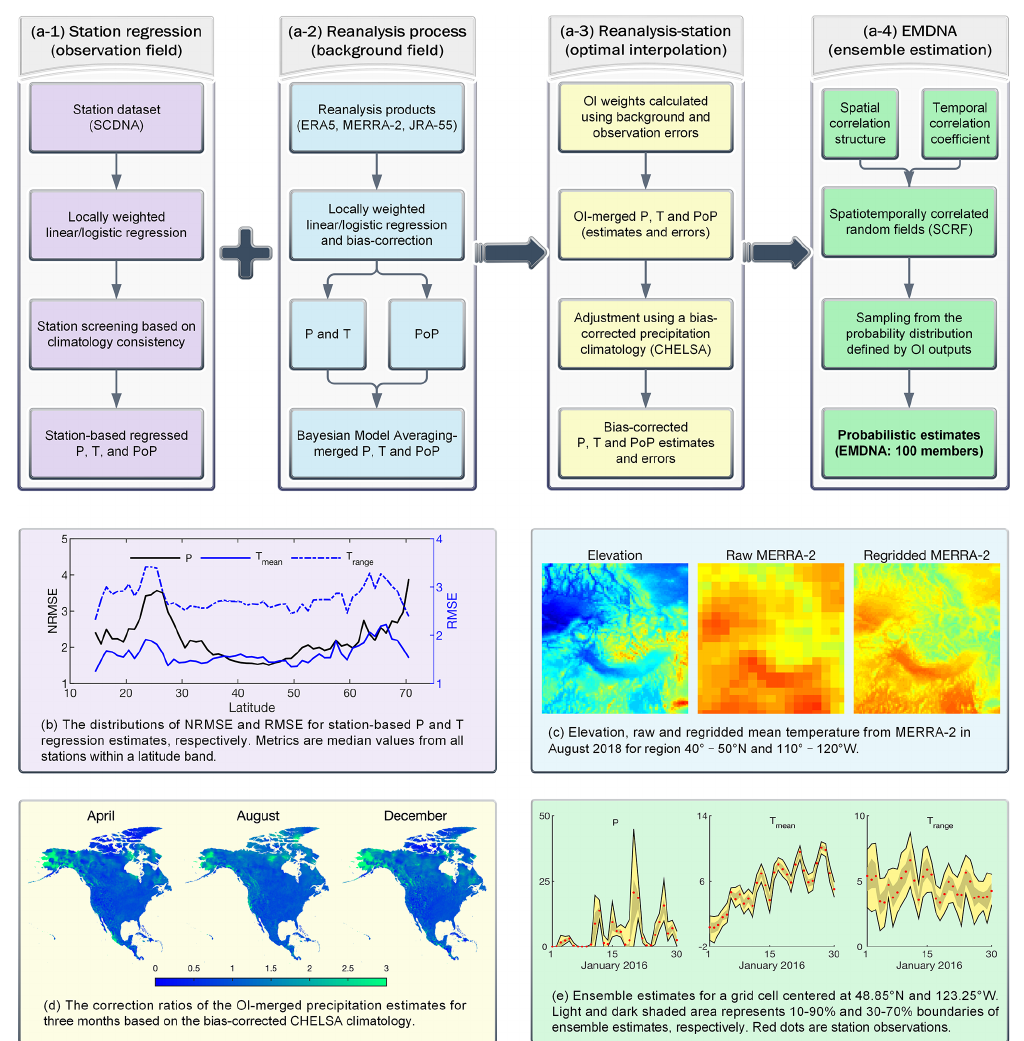
Figure 2. (a) The flowchart outlining the main steps for producing EMDNA. P represents precipitation and T represents temperature. (b–e) demonstrate output examples from ( a-1 to a-4 ), respectively. (b) Latitudinal distribution of the root mean square error (RMSE) for temperature and normalized RMSE (NRMSE) for precipitation (Sect. 3.1). (c) Example showing the mean temperature of MERRA-2 be- fore and after regridding (Sect. 3.2). (d) The correction ratios calculated using precipitation climatology from the bias-corrected CHELSA (Sect. 3.3). (e) Example of the ensemble-based distributions of precipitation and temperature estimates from EMDNA (Sect.